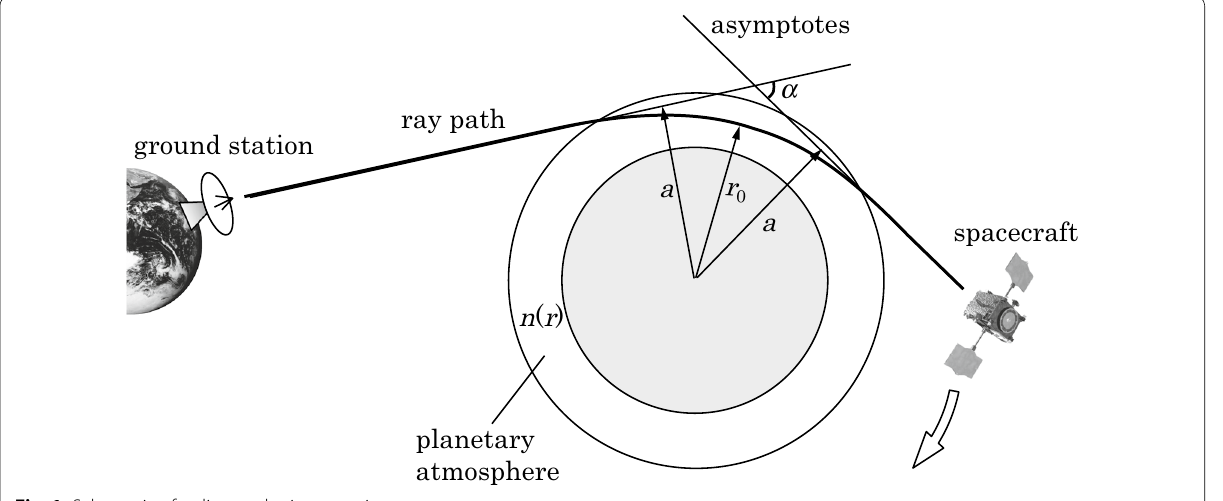
Fig. 1 Schematic of radio occultation